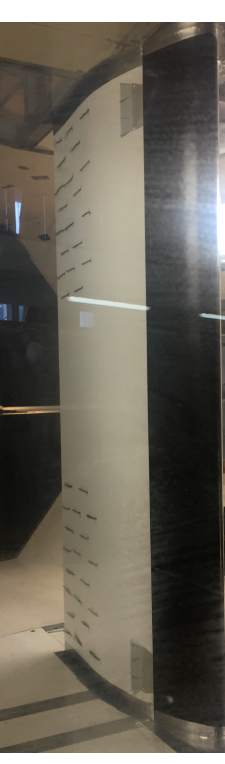
Figure 6. Example of tuft visualisation obtained for a clean airfoil (i.e. no tripping) with a slat at Re = 1 . 5 × 10 6 and a small angle of